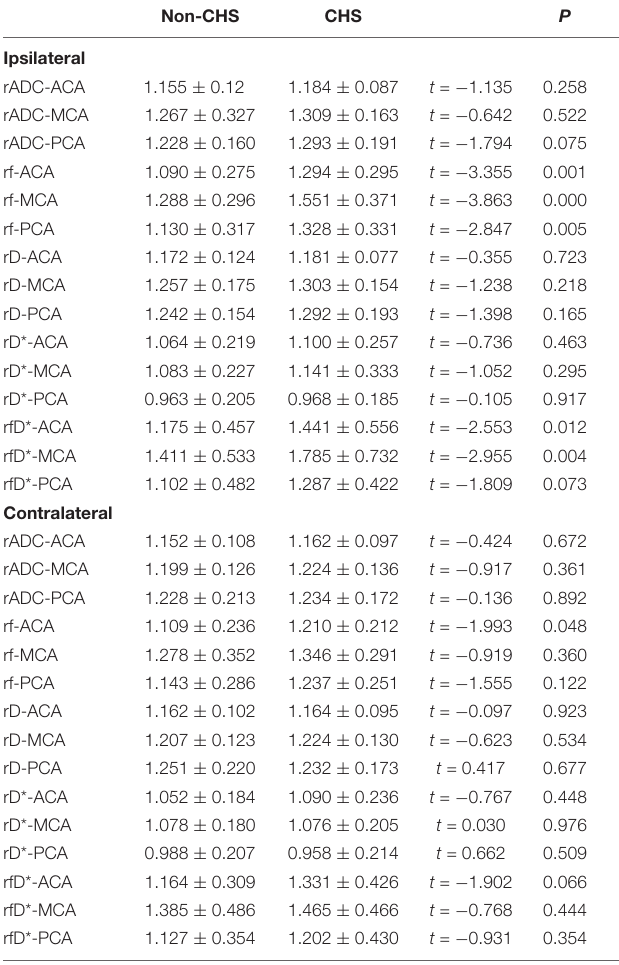
TABLE 4 | Preoperative microvascular perfusion status of the CHS and non-CHS groups.